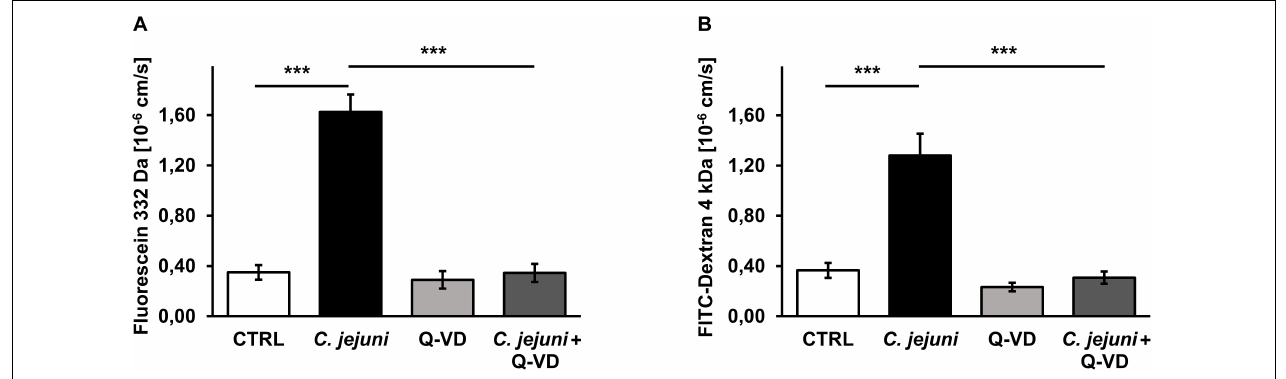
FIGURE 3 | Epithelial permeability toward macromolecules in C. jejuni -infected co-cultures 22 h post-infection. Co-cultures of HT-29/B6-GR/MR and THP-1- cells were infected with C. jejuni with or without apoptosis inhibitor Q-VD-OPh. (A) Fluorescein flux and (B) FITC-Dextran flux across the epithelial monolayer were measured after 22 h of C. jejuni infection. The flux measurements were performed in the cell monolayer filter supports and are presented as mean values ± SEM, n = 6, *** p < 0.001, unpaired Student’s t -test with Bonferroni-Holm correction for multiple comparisons.